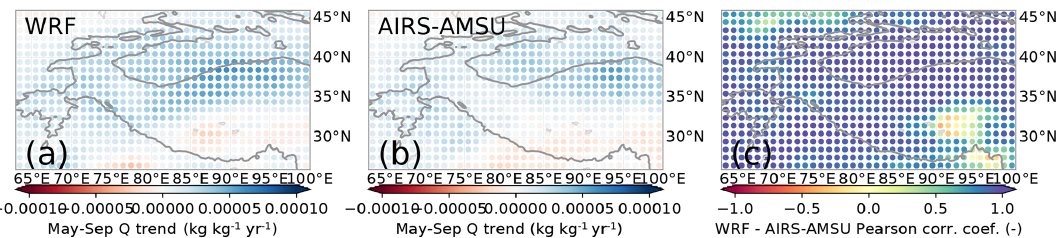
Figure 5. May–September mean specific humidity trends at 447.2hPa for WRF (a) and between 400 and 500hPa for AIRS–AMSU (b) between 2003 and 2010. Panel (c) shows the Pearson correlation coefficient between